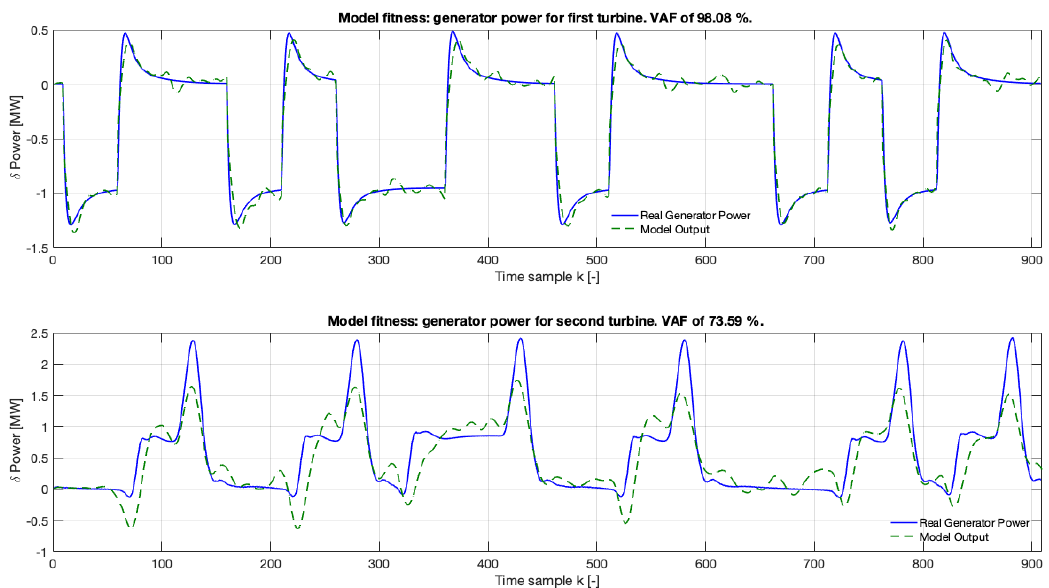
Figure 3. Best performing model validation results. Measurements from SOWFA are represented with a solid blue line and model response with a dashed green